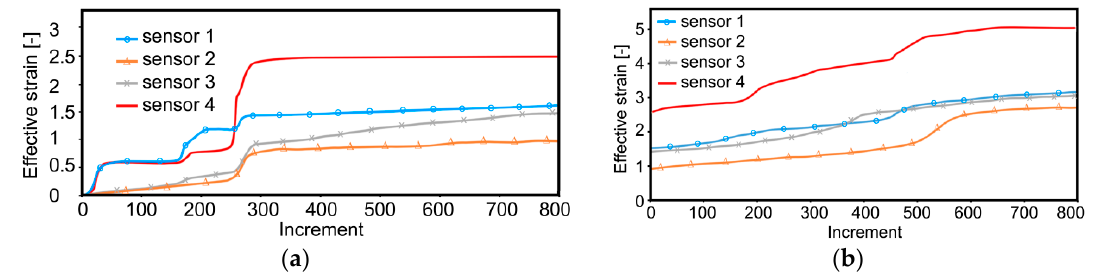
Figure 5. Imposed strain in individual sensors during: first pass ( a ); second pass ( b ).